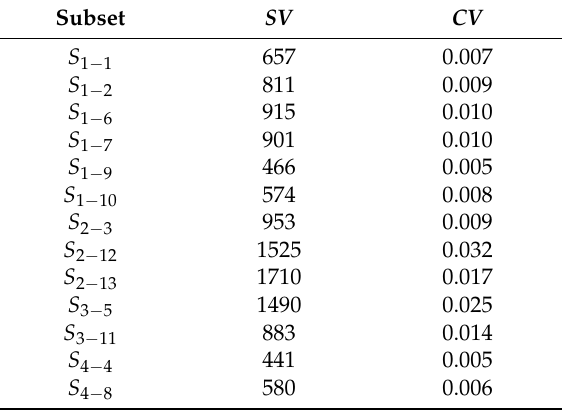
Table 4. The quantification of the extensional uncertainty of the all subsets (the SV is the sum of variance, and CV denotes the coefficient of variance). See notations in Table 3 for the name of